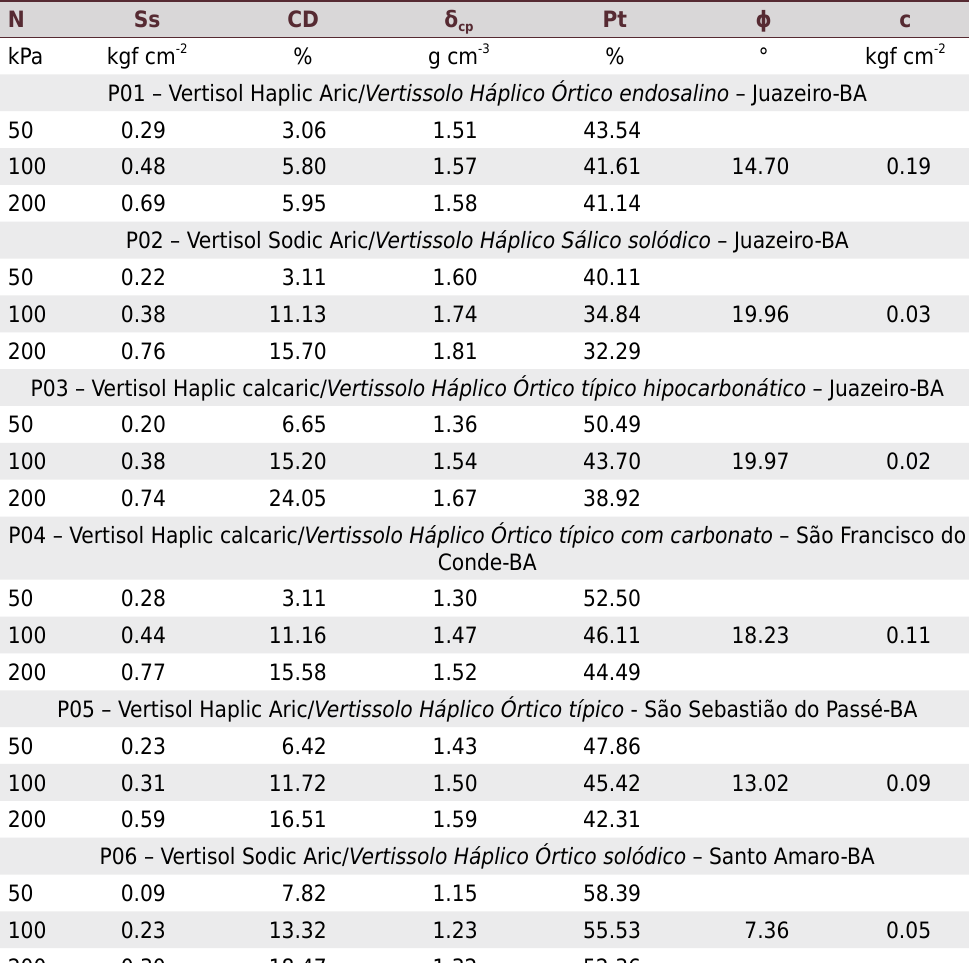
Table 8. Direct shear test applied to some kaolinite-rich Brazilian Vertisols N Ss